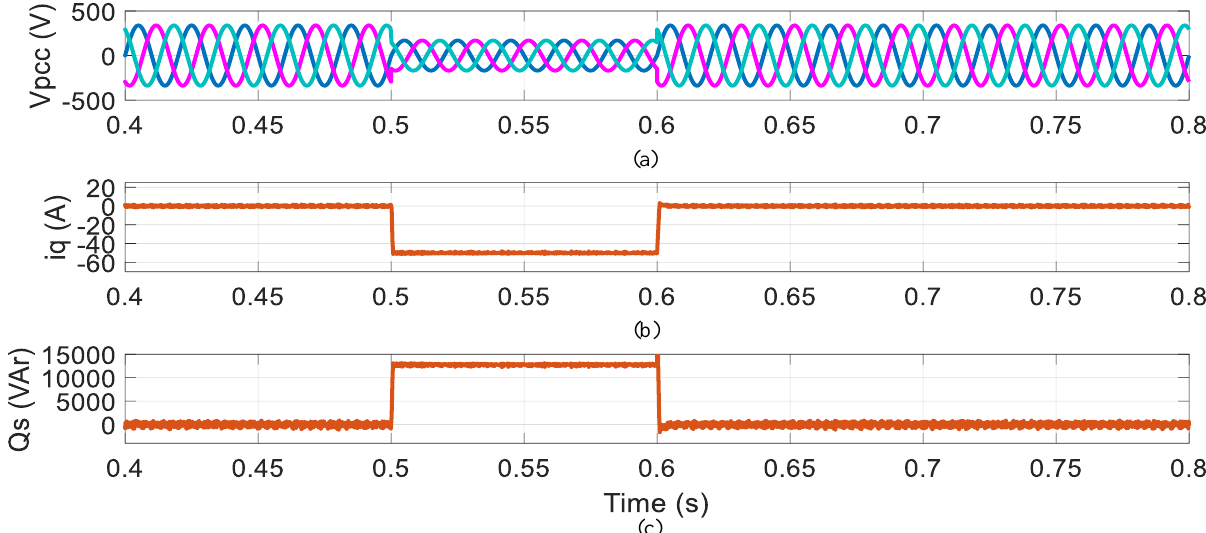
Fig. 14. Capability of the proposed STATCOM control for supporting reactive power during a voltage sag condition: (a) voltage at PCC; (b) q -axis source current component (reactive current); (c) reactive power support to the source